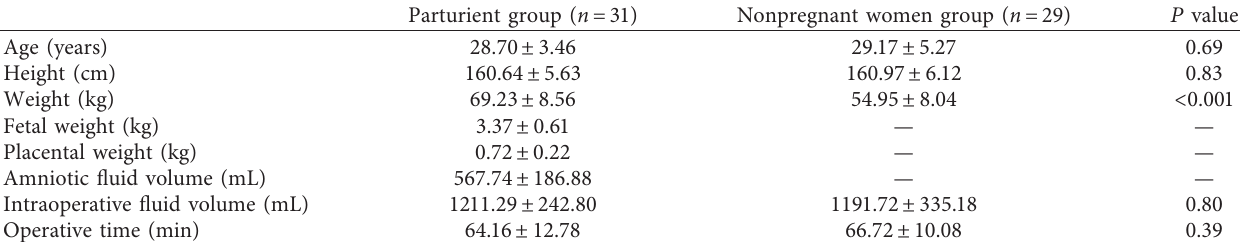
Table 2: Demographic data of the study subjects.